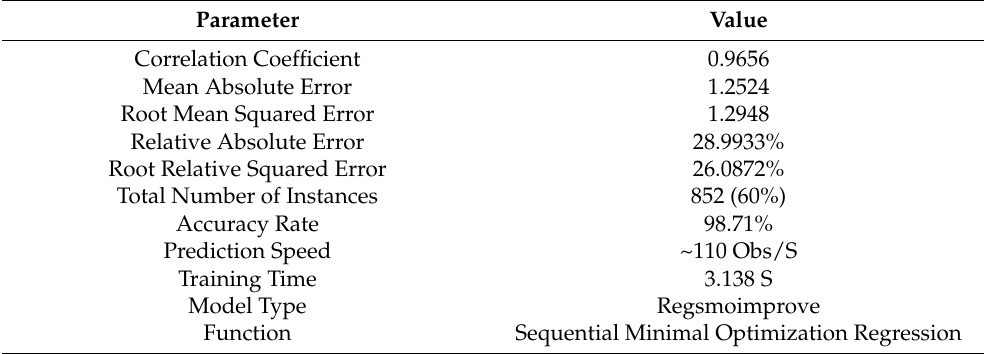
Table 3. Sequential minimal optimization regression